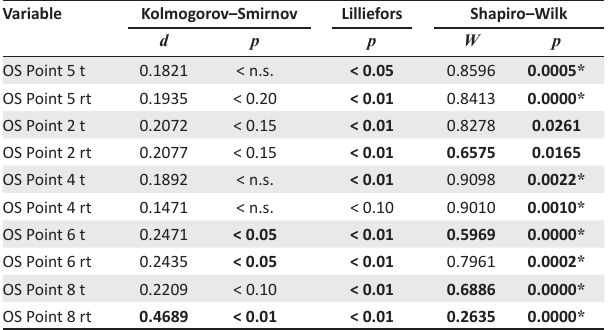
TABLE 2: Probability values for Kolmogorov–Smirnov, Lilliefors and Shapiro–Wilk tests for oscillatory sensitivity test and retest for the five main points investigated in the macular field test (MF 9).